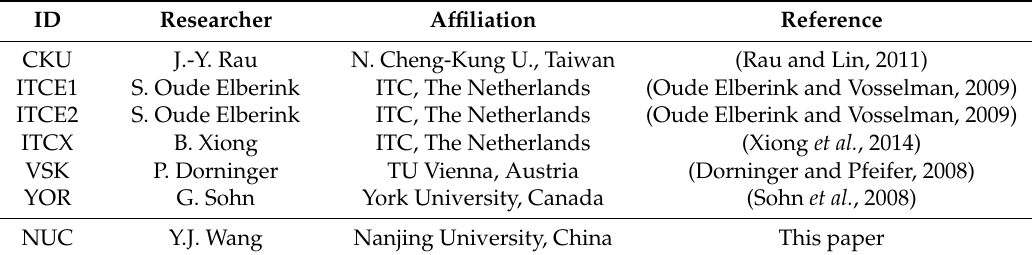
Table 4. Overview of the reconstruction methods. ID : Identifier of the method used in this paper. Researcher / Affiliation : name and affiliation of the person submitting the results. Reference : a reference where the method is described.